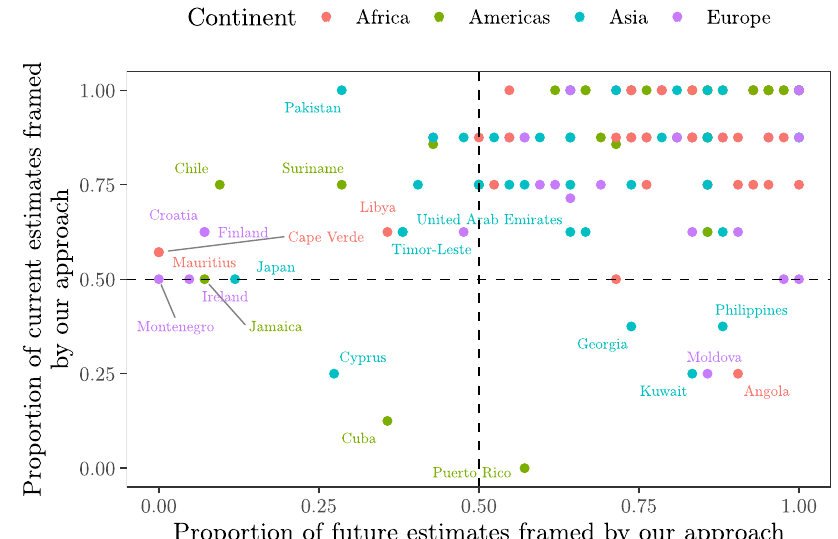
Fig. 5 Proportion of current and future irrigation water withdrawal values yielded by GMs that are framed by our predictions. The proportion in the y axis is taken over eight GMs (e.g., a dot closer to y = 1 means that our range of predictions covers all eight estimates yielded by GMs), whereas in the x axis it is taken over four GMs running on different combinations of the Shared Socioeconomic Pathway 2 (SSP2) and RCPs (e.g., two combinations for PCR- GLOBWB, fi ve for LPJmL, fi ve for H08, two for MPI-HM). See Puy 95 , p. 45 for a full speci fi cation of the combinations. A dot closer to x = 1 means that our range of predictions covers all these 14 estimates. Only the countries showing <50% in either the x or the y axis are labelled.